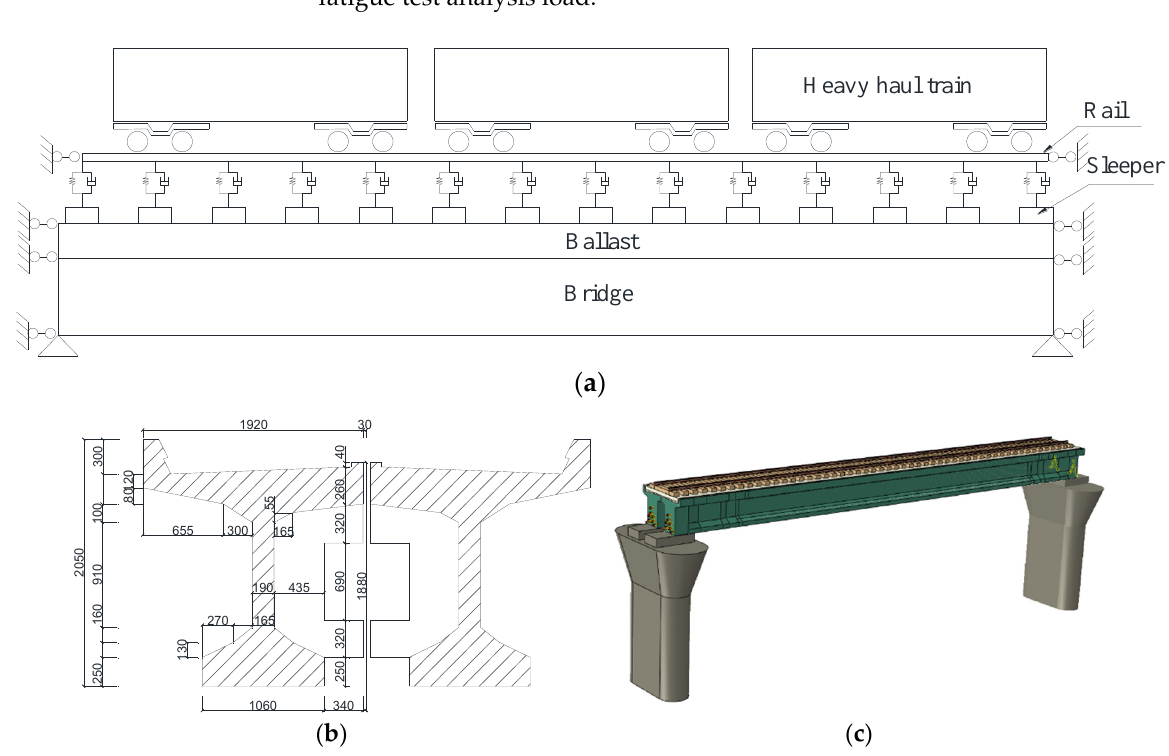
Figure 15. The finite element analysis model of the track-bridge: ( a ) The vehicle-rail-bridge system coupling model; ( b ) The cross-sectional form (unit: mm); ( c ) The finite element model.